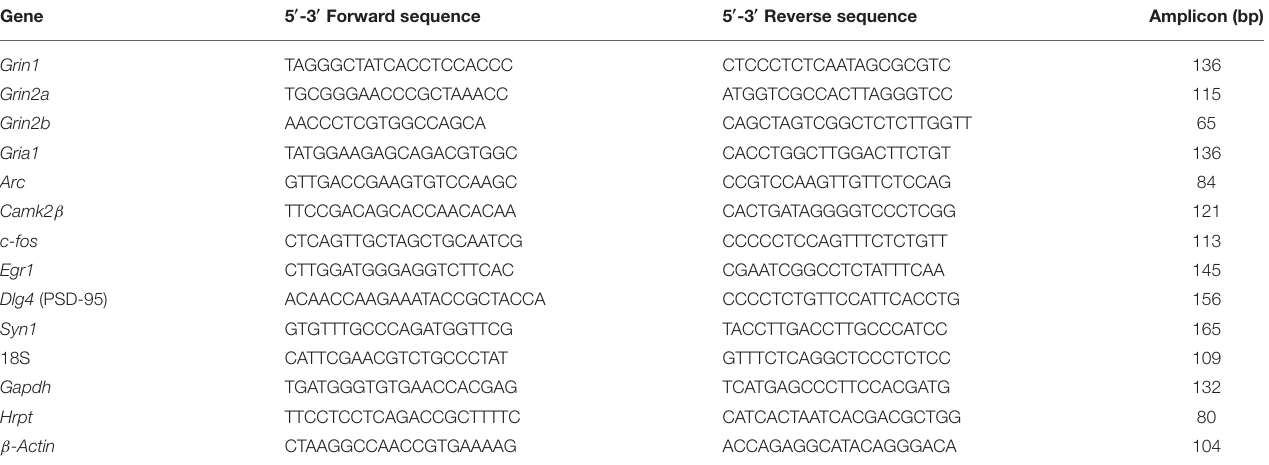
TABLE 1 | Nucleotide sequences of primers used for qRT-PCR.